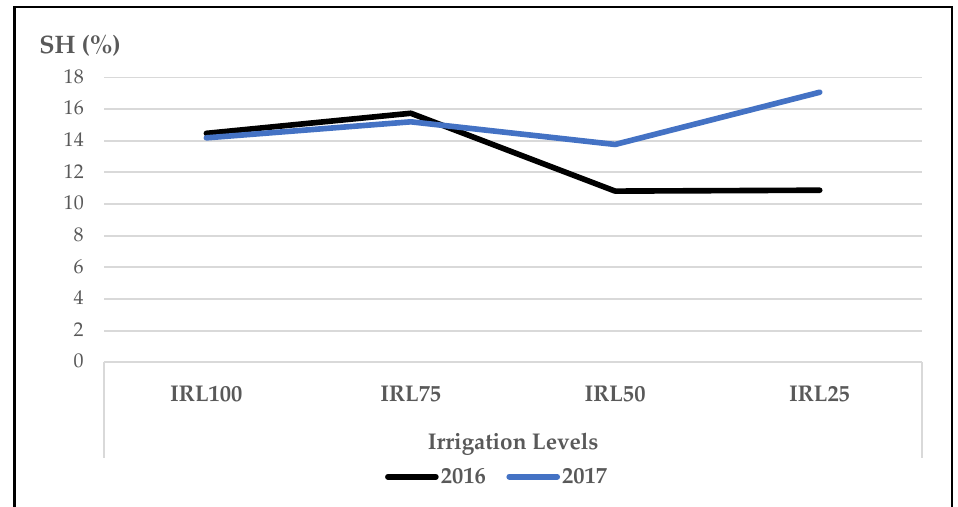
Figure 4. Mean values of SH (%) at different IRLs of O. basilicum L. essential oil; SH: sesquiterpene hydrocarbons; IRL 100 = 100% FC; IRL 75 = 75% FC; IRL 50 = 50% FC; IRL 25 = 25% FC without SM.